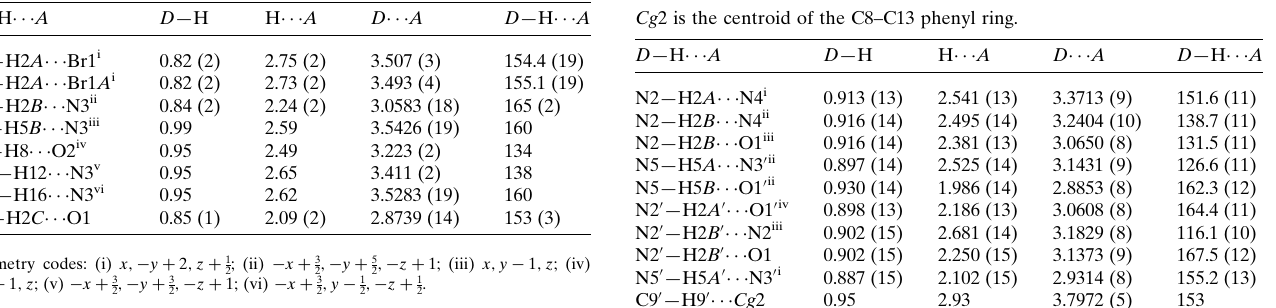
Table 1). Further N—H (cid:2) (cid:2) (cid:2) Br and O—H (cid:2) (cid:2) (cid:2) O hydrogen bonds,